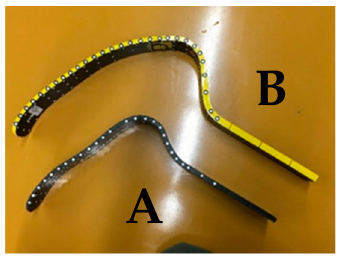
Figure 2. The commercially available blades (A and B) selected as measurement objects. Impact experiments were conducted on each blade with three different categories (numbers 1, 3, and 5).